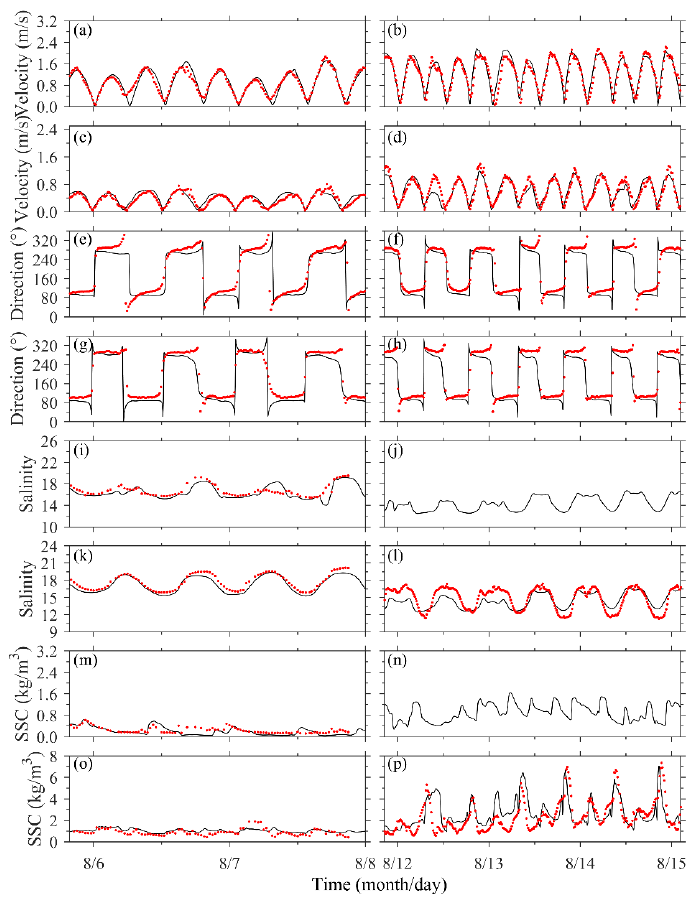
Figure 4. Comparisons between the observed data (red dots) and simulated results (black line) at measured site A. The left column represents neap tide, and the right column represents spring tide. ( a , b ) Surface velocity; ( c , d ) bottom velocity; ( e , f ) surface direction; ( g , h ) bottom direction; ( i , j ) surface salinity; ( k , l ) bottom salinity; ( m , n ) surface SSC; and ( o , p ) bottom SSC (loss of surface SSC during spring tide due to the typhoon). Table 2. Correlation coefficients (CC), root-mean-square error (RMSE), and skill scores (SS) for comparison of modeled and observed water velocity, salinity, and suspended sediment at the measuring